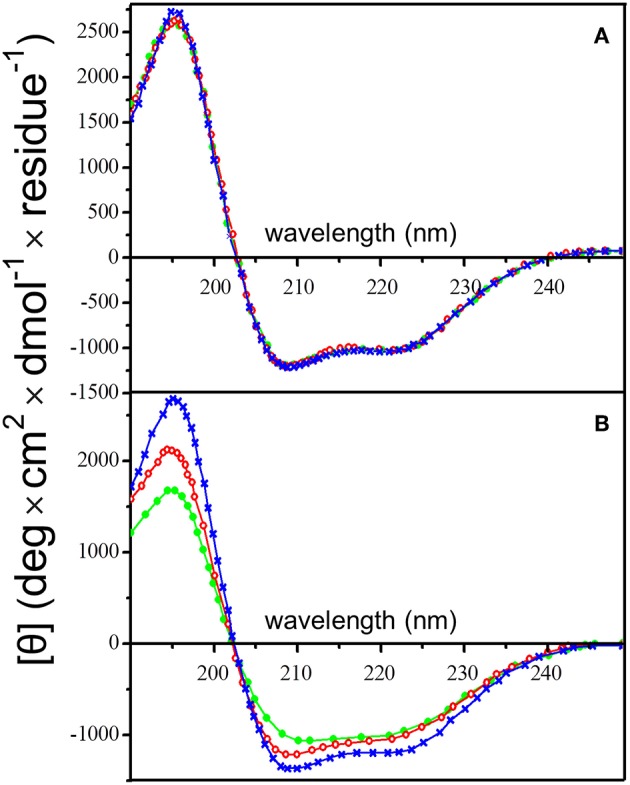
Changes in the insulin secondary structure in the presence of PEG-OH-modified CdSe/ZnS QDs. Circular dichroism spectra of human insulin (2 mg/ml) were recorded (A) in the absence or (B) in the presence of QDs (3.44 μM). The QDs were also incubated alone (a control sample), when they did not display a noticeable CD signal (baselines in B). All solutions were incubated at 37°C for 24 h in a sodium phosphate buffer solution (pH 7.0) at 37°C; the CD spectra were recorded after 0 (blue), 12 (red), and 24 h (green).